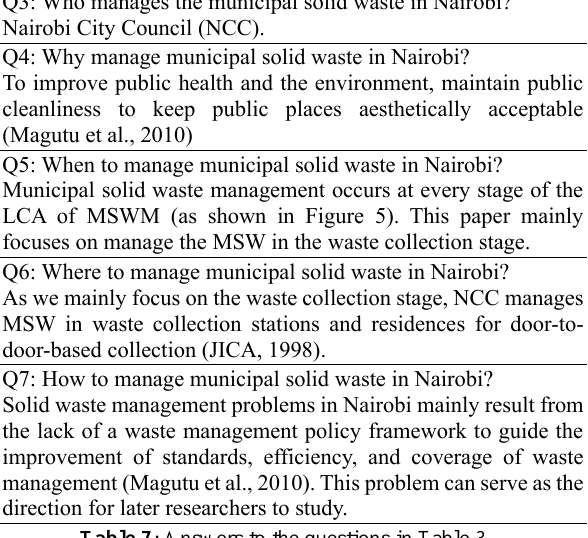
Table 7 : Answers to the questions in Table 3.